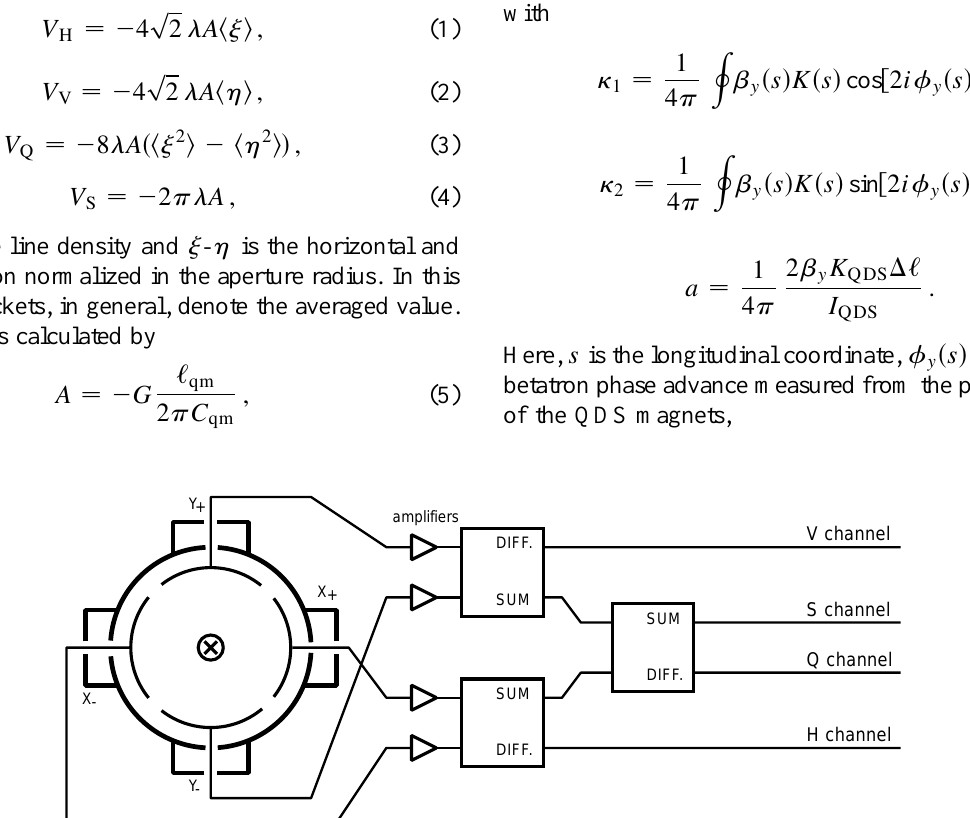
FIG. 1. Data processing system of the quadrupole beam monitor. The voltages of four electrodes (X 1 ,X 2 ,Y 1 ,Y 2 ) are amplified and processed into four channels (V, H, Q, S). The hybrid junctions output the sum (SUM) and difference (DIFF) of the input signals.